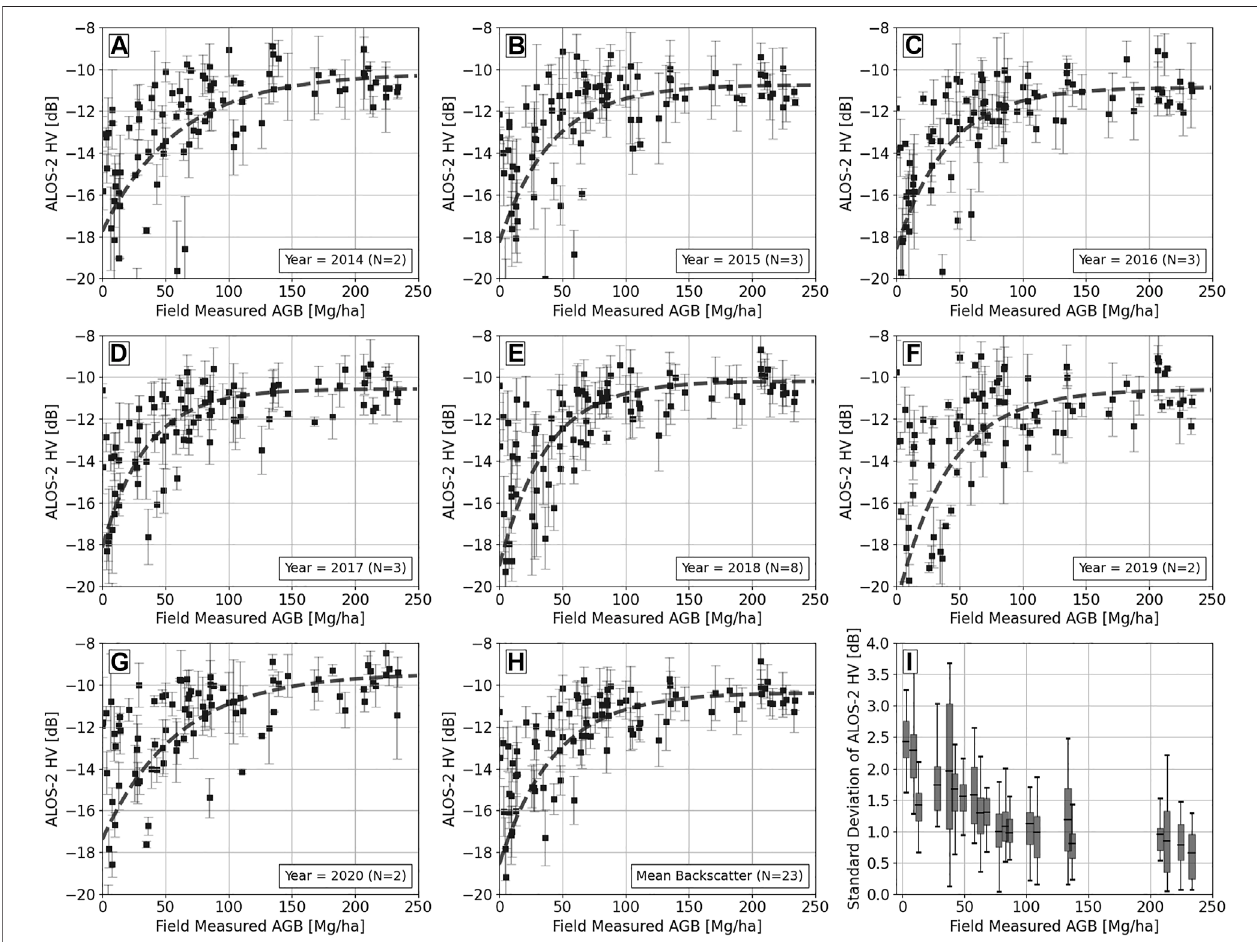
FIGURE 7 | Mean annual ALOS-2 HV backscatter from 2014 to 2020 (A – G) plotted as a function of forest AGB with the WCM model curve. The whisker plots are the standard deviation of the backscatter. N shows the number of acquisitions available for each year over the site. The plot (H) shows the mean backscatter across all acquisitions plotted as a function of forest AGB. (I) is the HV backscatter multi-temporal standard deviation calculated for all acquisitions over the period 2014-2020.